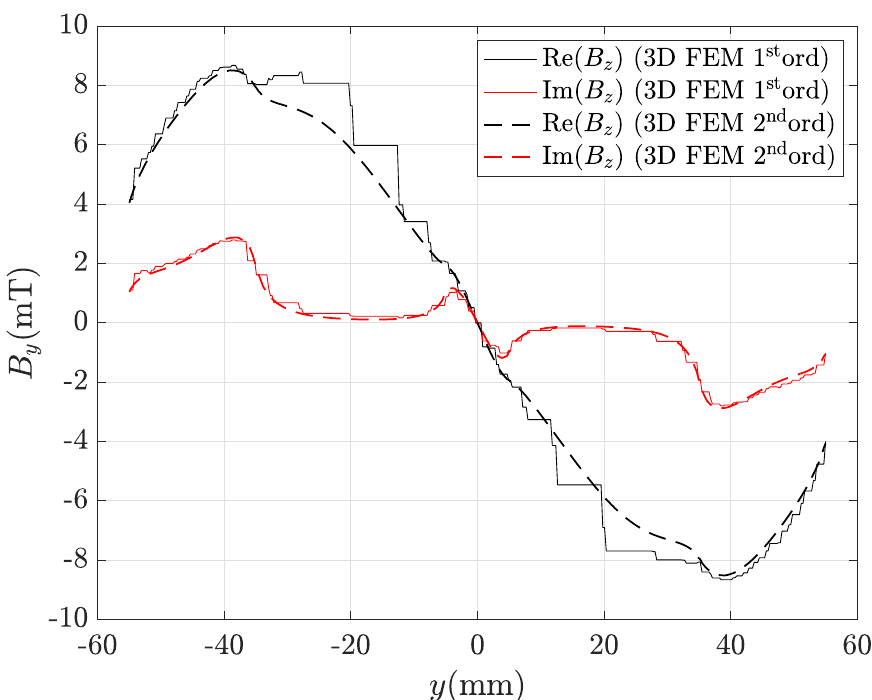
Figure 21. Real and imaginary parts of the magnetic flux density radial component B y along line AB depicted in Figure 8 computed by FEM with the coarsest mesh (69,702 tets for plate, 1,171,167 tets for air): first ord. 3D FEM is the straight line, second ord. 3D FEM (reference) is the dashed line.